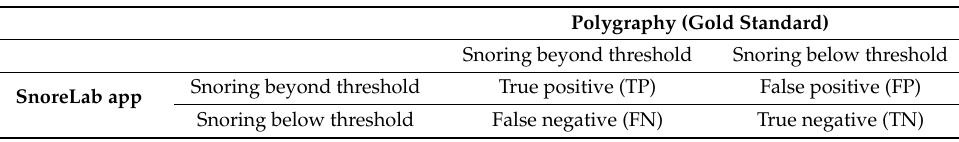
Table 1. Cross table for calculation of sensitivity, specificity, positive and negative prediction values, prevalence and